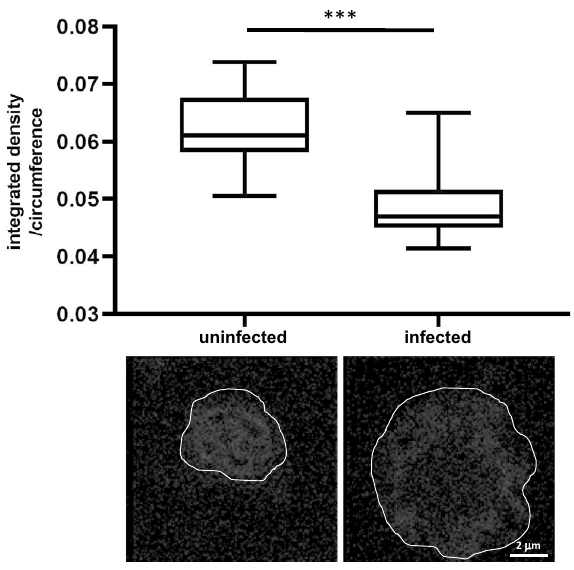
Figure 4. HCV decondense interphase chromatin in infected cells. Huh-7.5 cells were grown untreated or infected with HCV. Cells were processed for two-photon microscopy and analyzed. 30 nuclei were analyzed from each cell cycle phase. *** p <